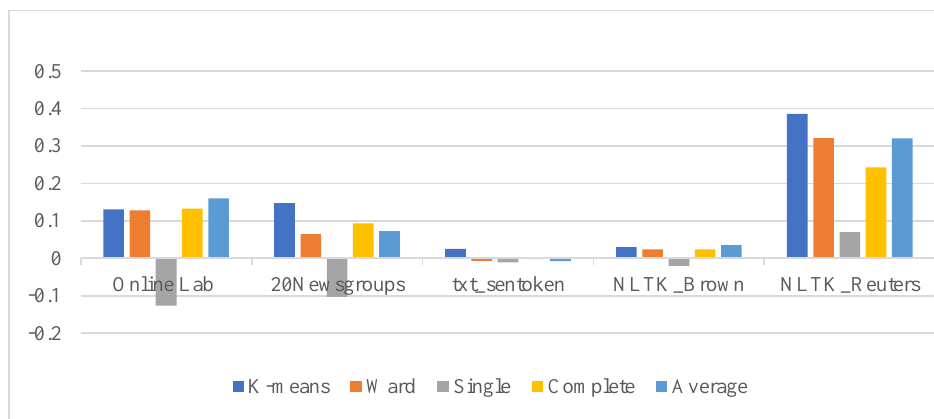
Figure 8. Similarity ratio without preprocessing (WoPP).